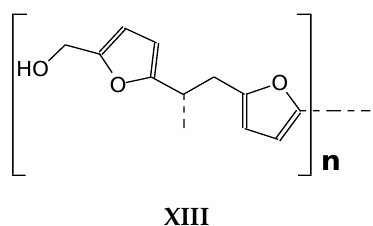
Scheme 8. Examples of structures produced in the foams coreaction showing that flavonoid monomers and oligomers do react with complex oligomeric humins structures.